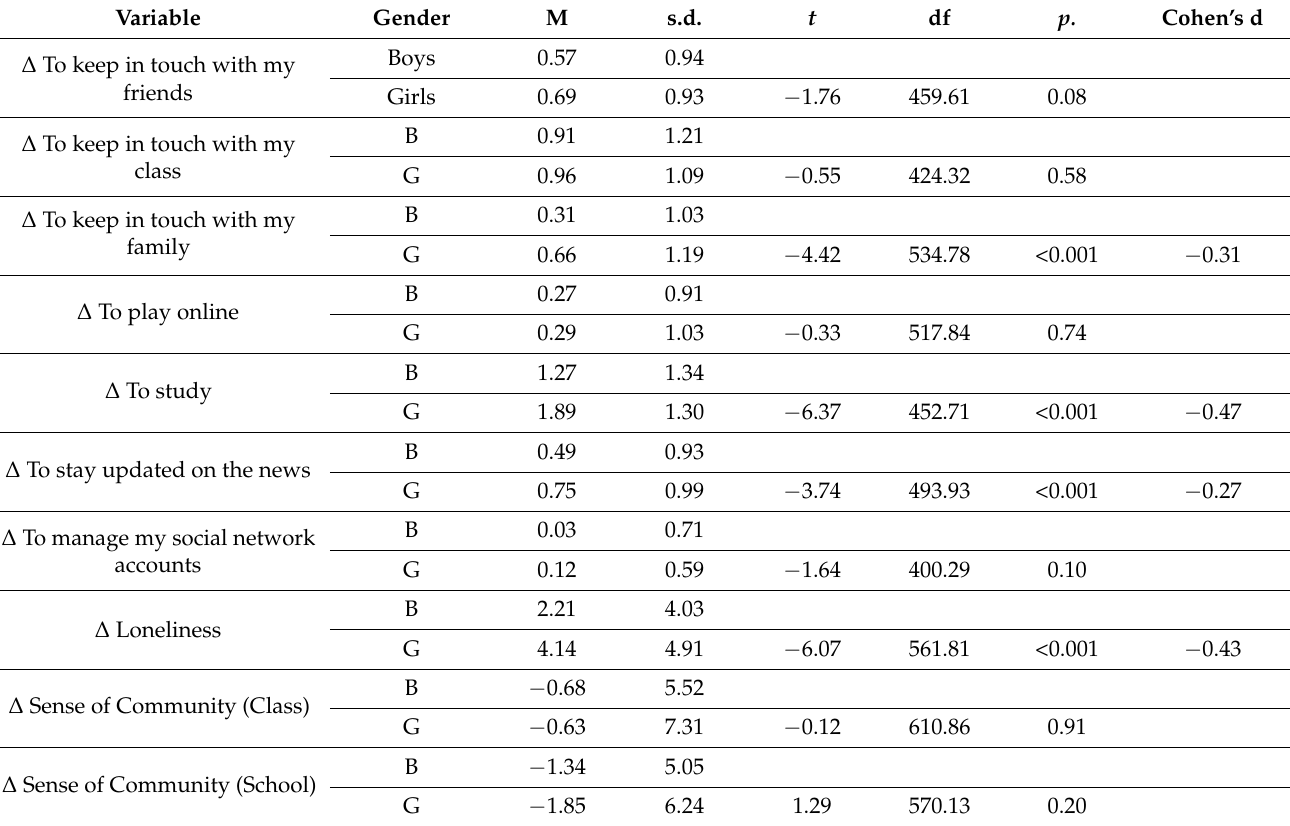
Table 3. Gender-related differences regarding the pre and post variations in technology use, SOC, and